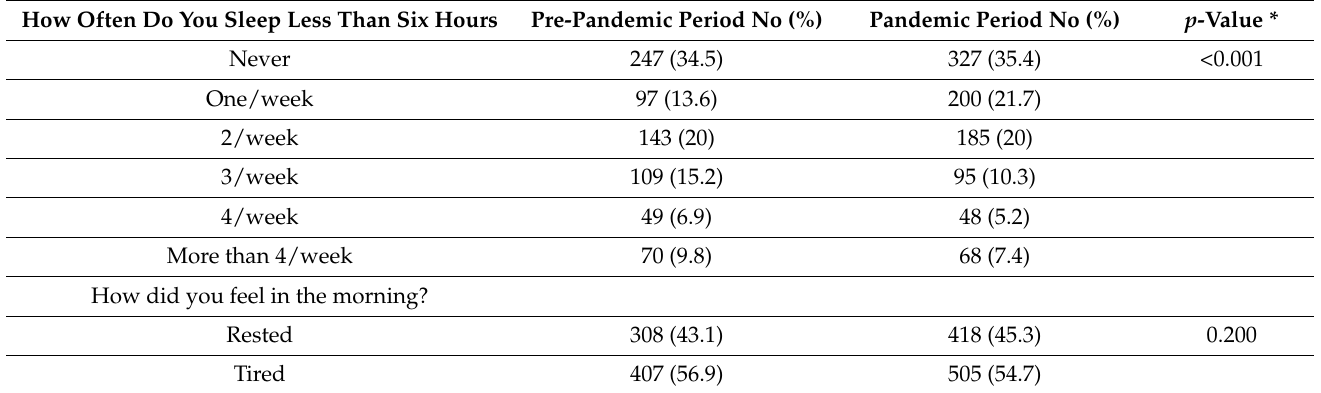
Table 10. Sleep quantity and quality.